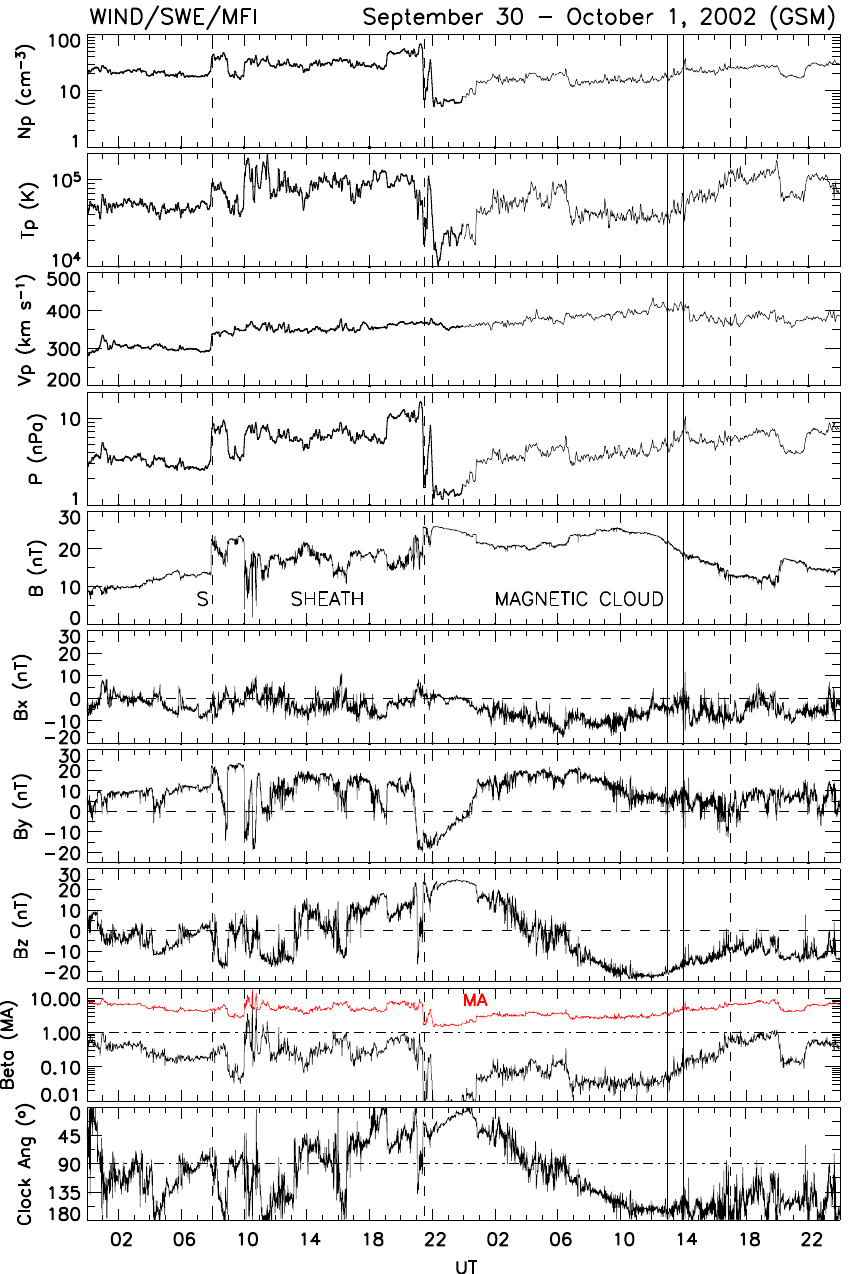
Fig. 4. Solar wind plasma and IMF observations from spacecraft Wind during the interval 00:00UT (30 September)–24:00UT (1 October), 2002. Panels from top to bottom show (i) proton density, (ii) proton temperature, (iii) bulk speed, (iv) solar wind dynamic pressure, (v) IMF total field, (vi–viii) the field components B x , B y , B z , (ix) Alfv´en-Mach number (MA; red) and proton beta, and (x) the IMF clock angle ( θ ). The shock (S), sheath, and the cloud proper are marked by dashed vertical guidelines. Interval in focus here (13:00–14:00UT) is also